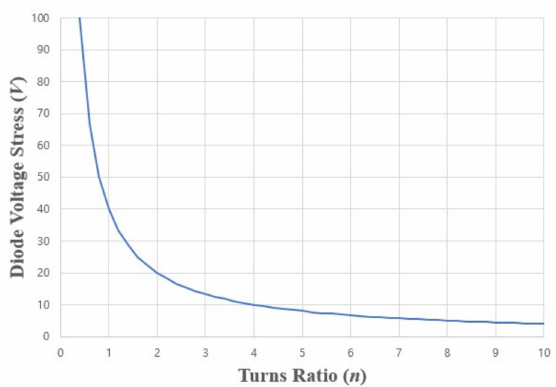
Figure 11. Relationship curve between diode voltage stress and turns ratio n